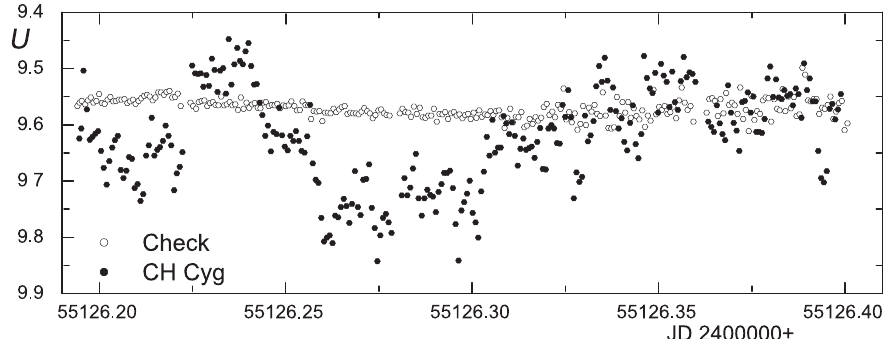
Fig. 3. High-time-resolution photometry of CH Cyg during its 2009 burst measured on 2009 October 21.